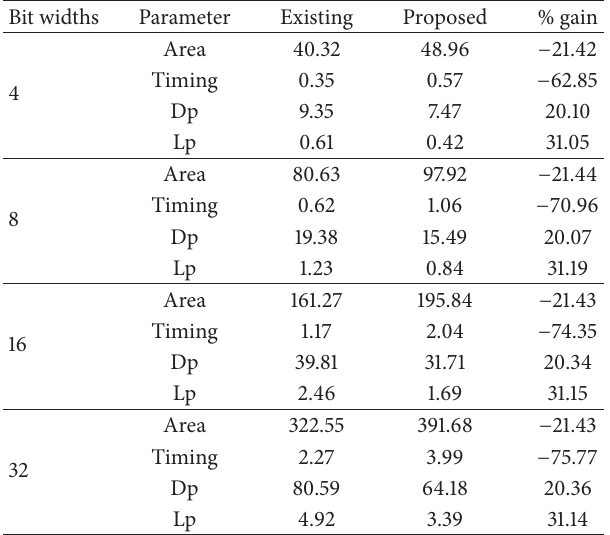
Table 1: Results of variable bit widths adder architecture using TSMC standard full adder cell and proposed full adder cell.